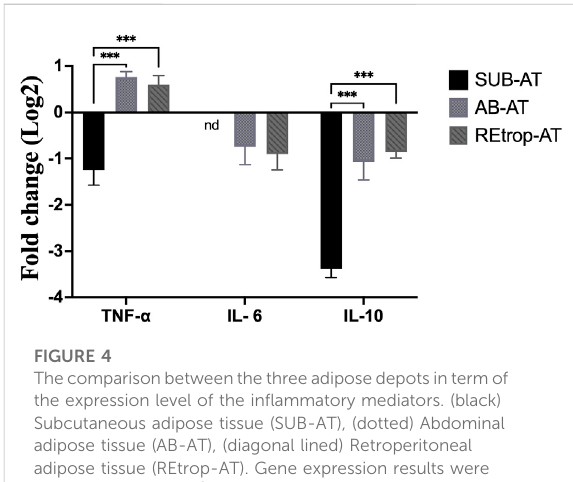
FIGURE 4 Thecomparisonbetweenthethreeadiposedepotsintermof the expression level of the in fl ammatory mediators. (black) Subcutaneous adipose tissue (SUB-AT), (dotted) Abdominal adipose tissue (AB-AT), (diagonal lined) Retroperitoneal adipose tissue (REtrop-AT). Gene expression results were generated using 2 − ΔΔ Ct method and the mean fold change (log2) values ofthetargets mRNAexpression werenormalizedto control samples and theendogenous gene. Two-way ANOVA and Tukey ’ s post hoc test was performed using GraphPad Prism version 9, ( n = 6). *** p < 0.001. nd, not